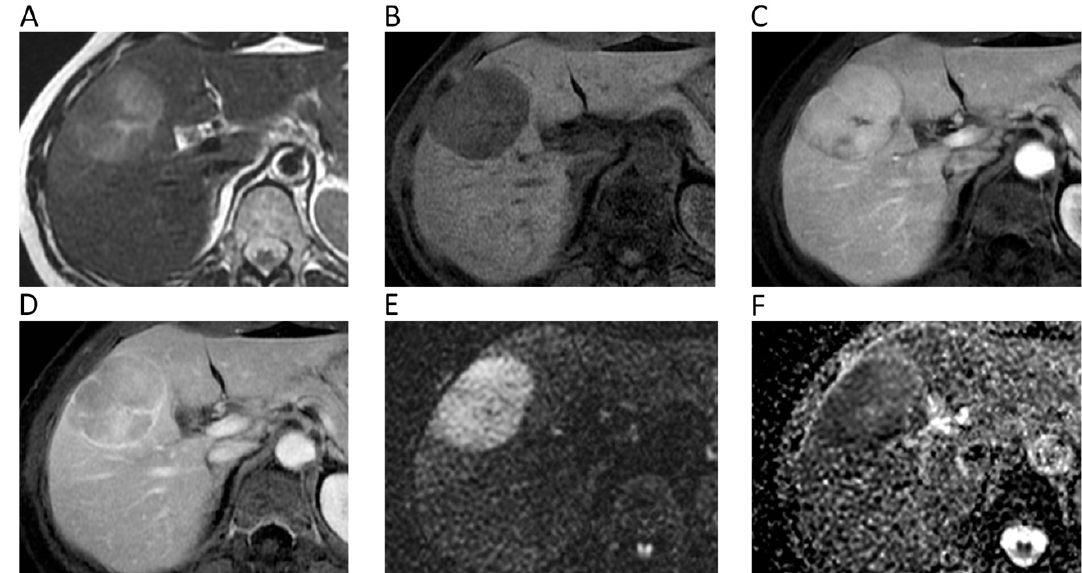
Figure 5. Liver MRI of a 54-year-old female patient with histologically proven hepatocellular carcinoma (HCC) on her healthy liver. Axial T2w ( A ) and pre-contrast fat-suppressed 3D-gradient-echo T1w ( B ) images show a large mass with strong contrast enhancement on the arterial phase ( C ), wash-out and rim enhancement on the portal phase ( D ), high signal intensity on b = 800 DWI image ( E ), and low ADC values (mean ADC: 1.018 × 10 − 3 mm 2 / s) on the corresponding ADC map ( F ).